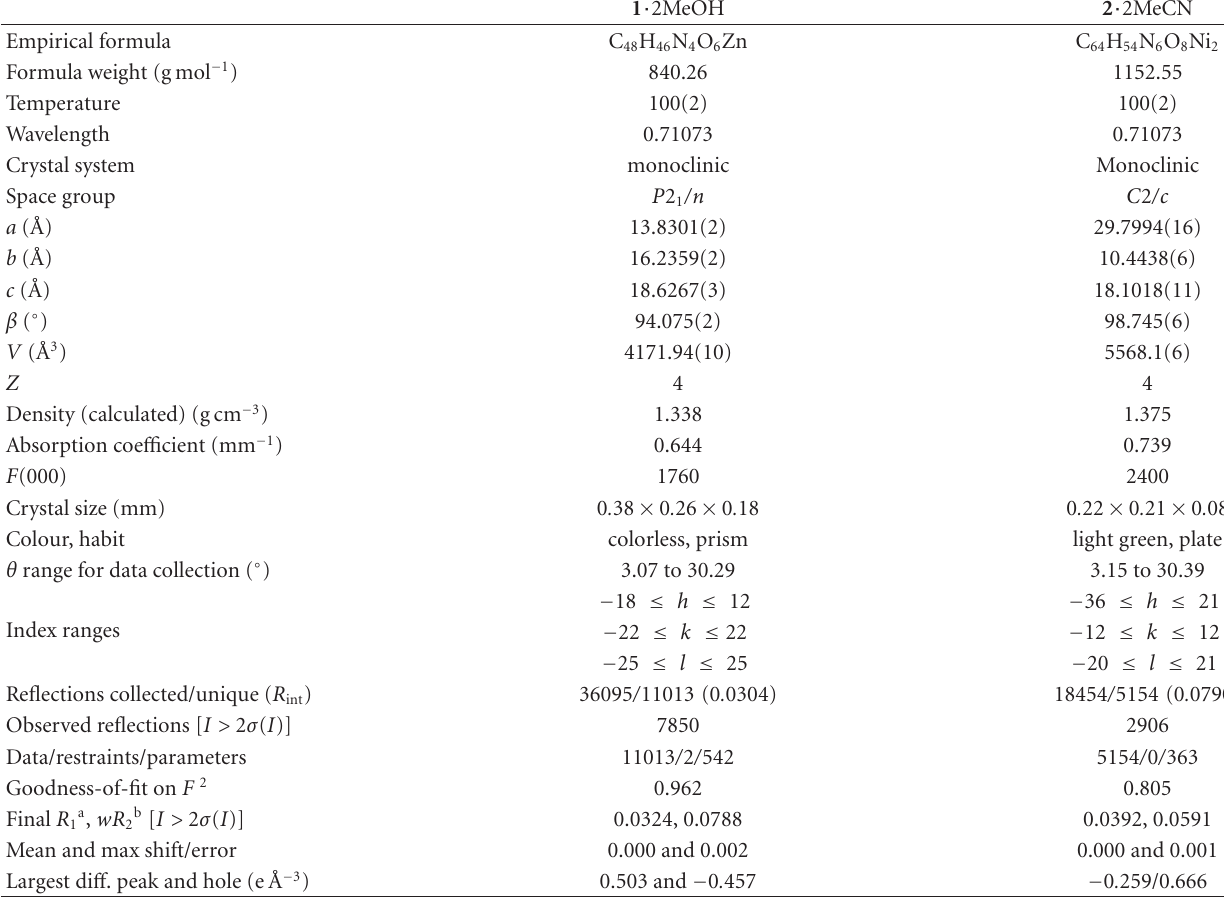
Table 1: Crystal data and refinement parameters for complexes 1 · 2MeOH and 2 ·